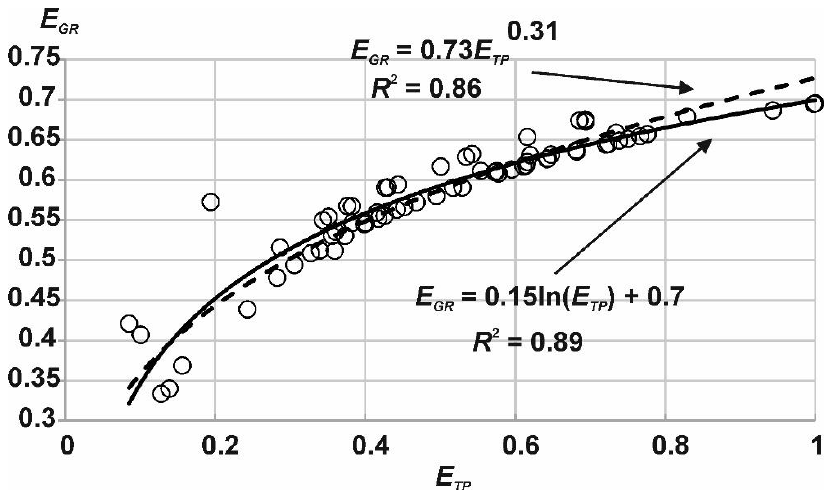
Figure 8. The relationship between total erosion potential from TEP and gully erosion risk from GER for the points along the bed profile of gully P-1, shown in Figure 2.